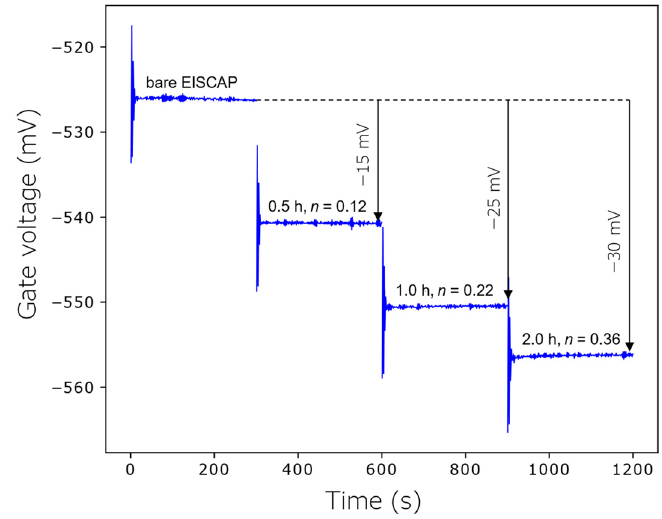
Figure 6. Dynamic ConCap signal change of the EISCAP decorated with positively charged AuNPs of different coverages n , corresponding to AuNP immobilization times of 0.5 h, 1 h and 2 h. It is well known that in electrolyte solution, the charge associated with the